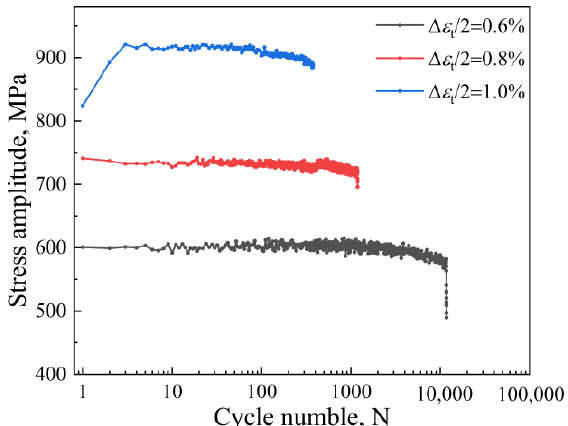
Figure 1. Cyclic stress response curves of experimental alloys at varying strain amplitudes during low-cycle fatigue deformation.